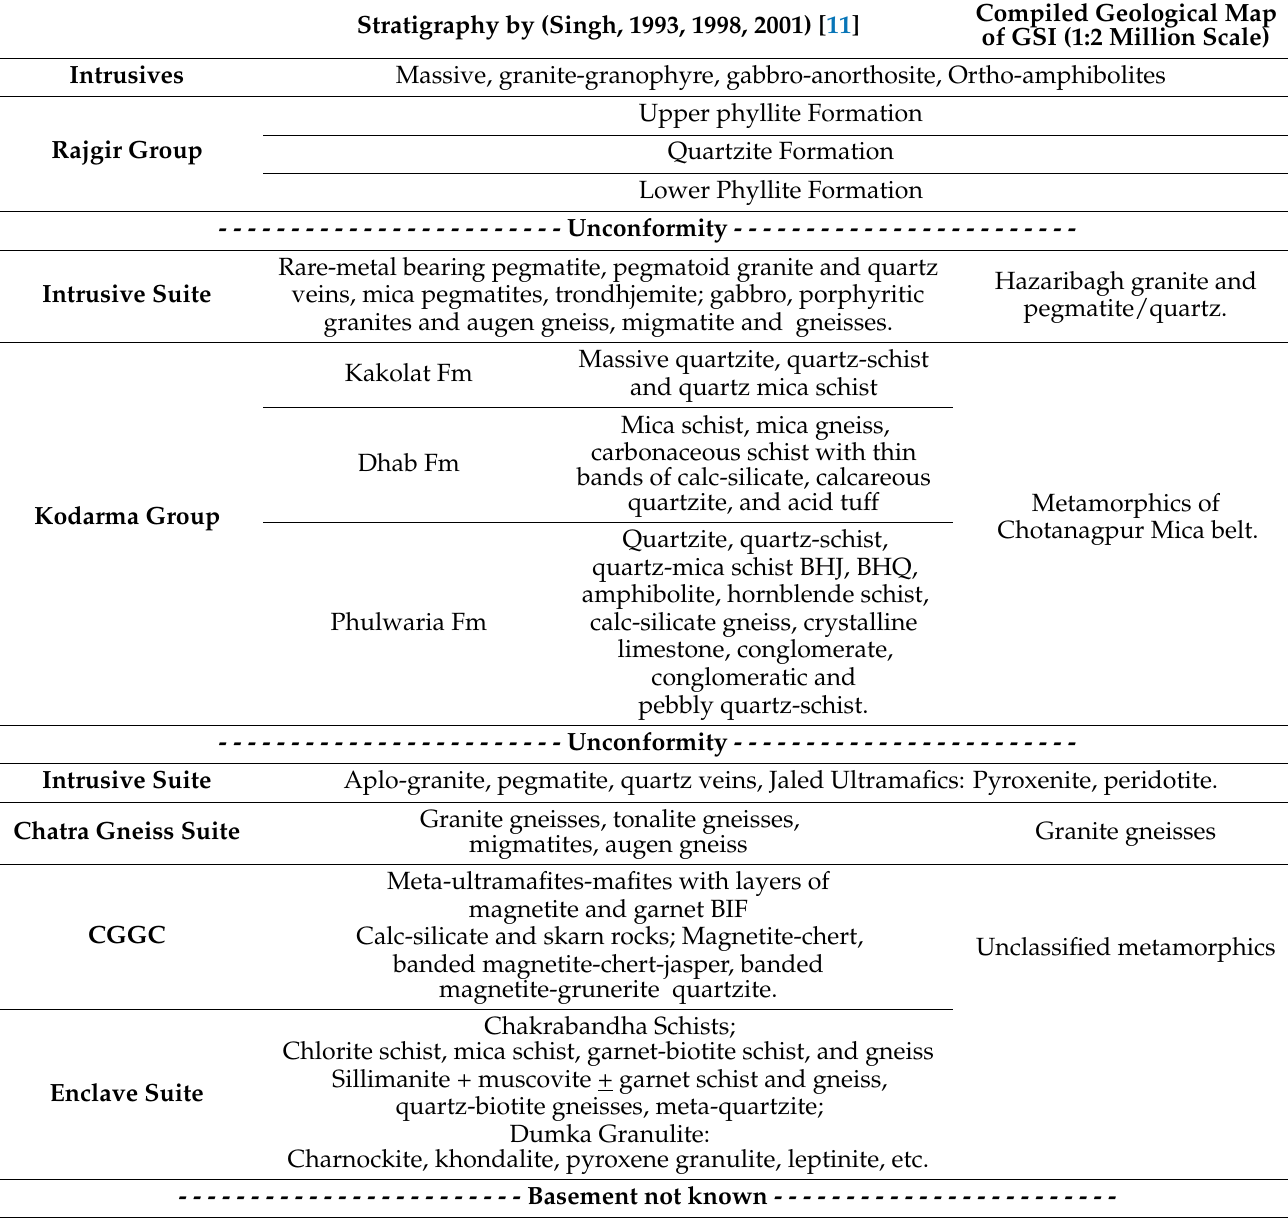
Table 1. The comparative stratigraphy of CGGC from Bihar as given in the geological map of GSI [7]. Stratigraphy by (Singh, 1993, 1998, 2001) [11]